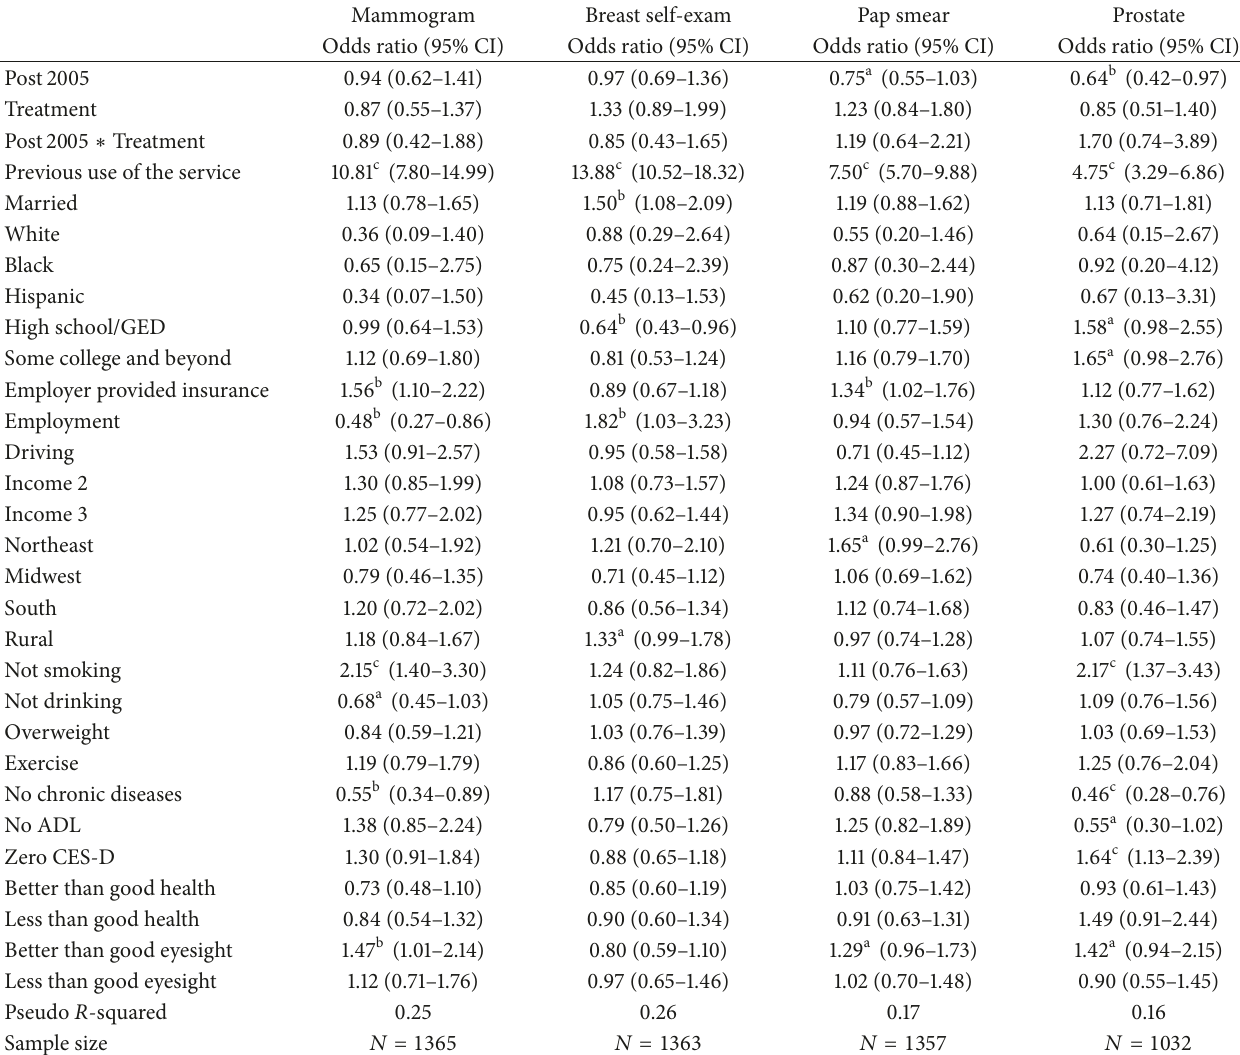
Table 2: Odds ratios derived from multivariate logit models for having a mammogram, breast self-exam, Pap smear, or prostate cancer screening (Health and Retirement Study data,